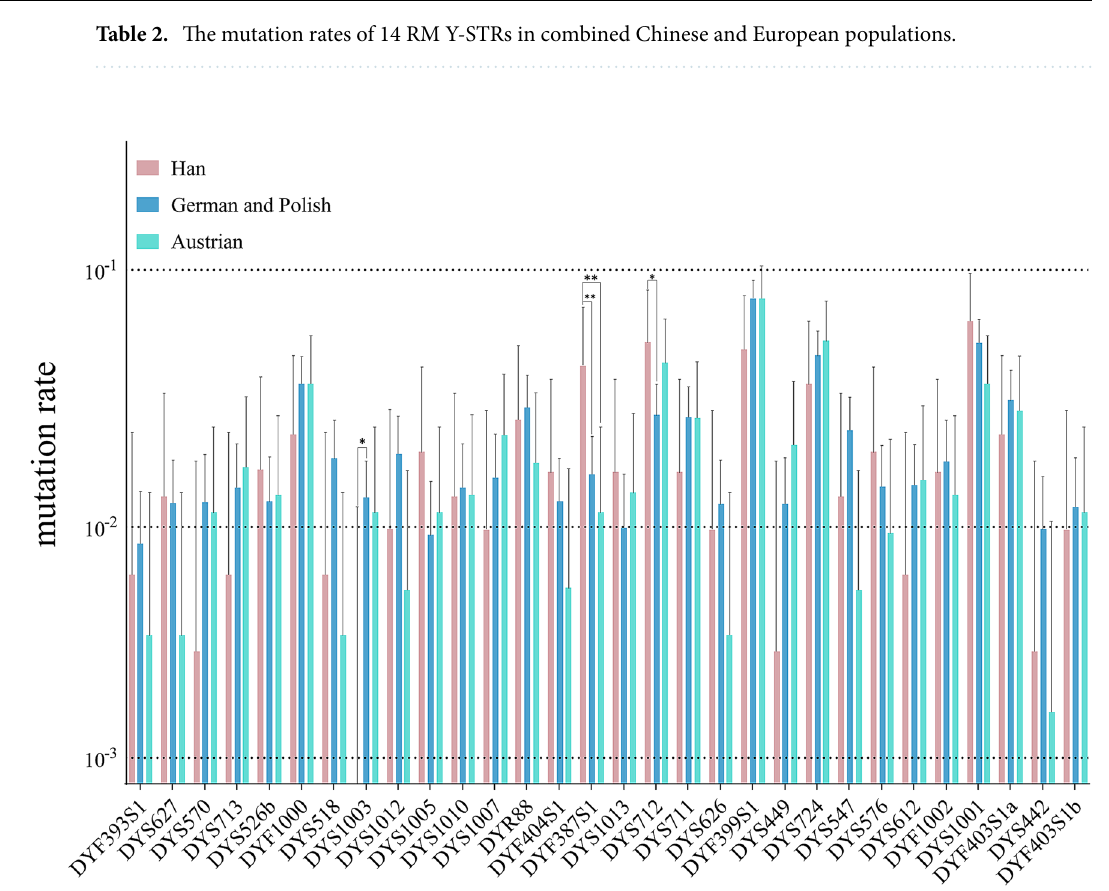
mutation rates between the two populations for each of the 14 RM Y-STR loci revealed significant differences at five of the loci (DYS570, DYS399S1, DYS547, DYS612 and DYF403S1b). The wide range of differences observed suggests that there are non-negligible differences in mutation between different continental groups. For the 30 Y-STR loci, Fisher’s exact test was performed for each pair of mutation events per locus between our studied group and European reference populations, as well (Fig. 2 and Supplementary Table S2) 9,17,19 . The